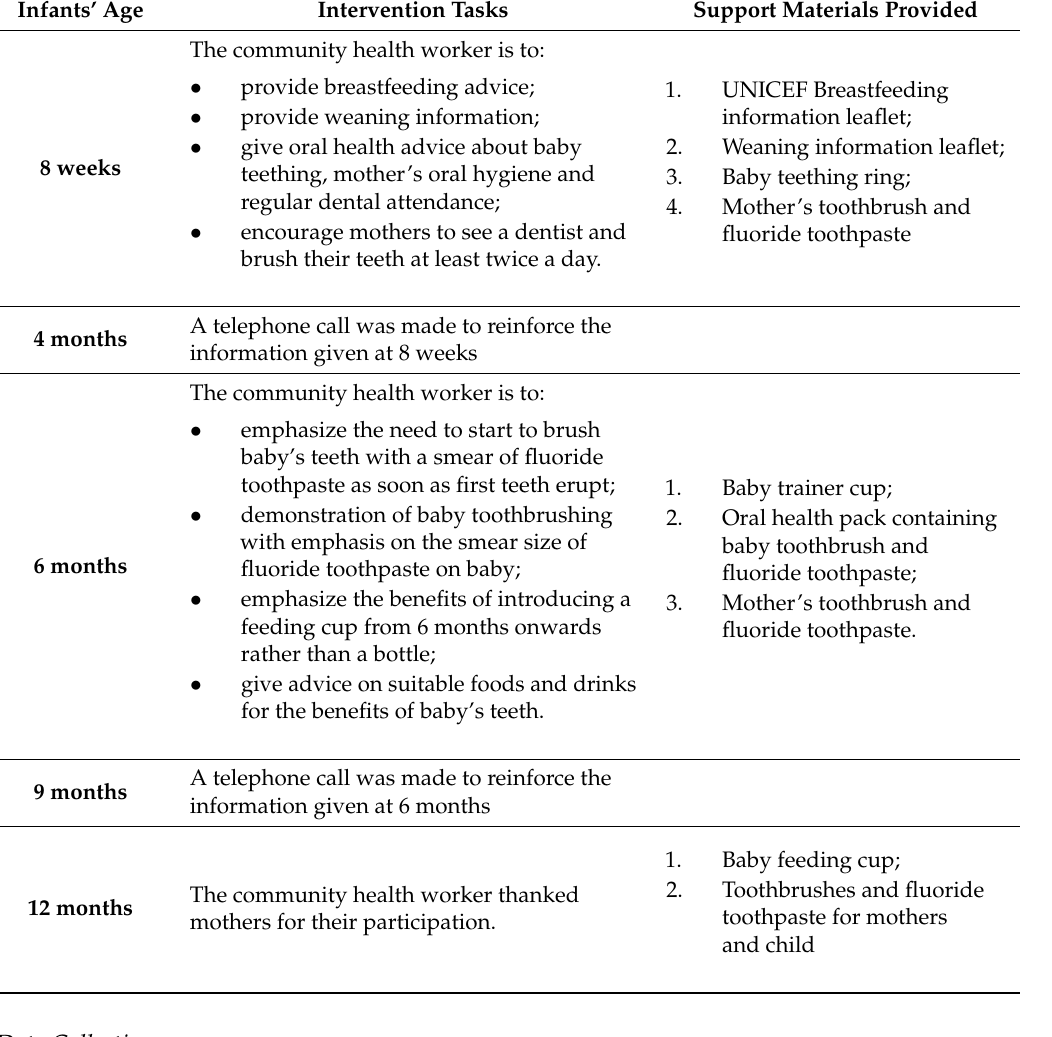
Table 1. The procedures of the intervention program